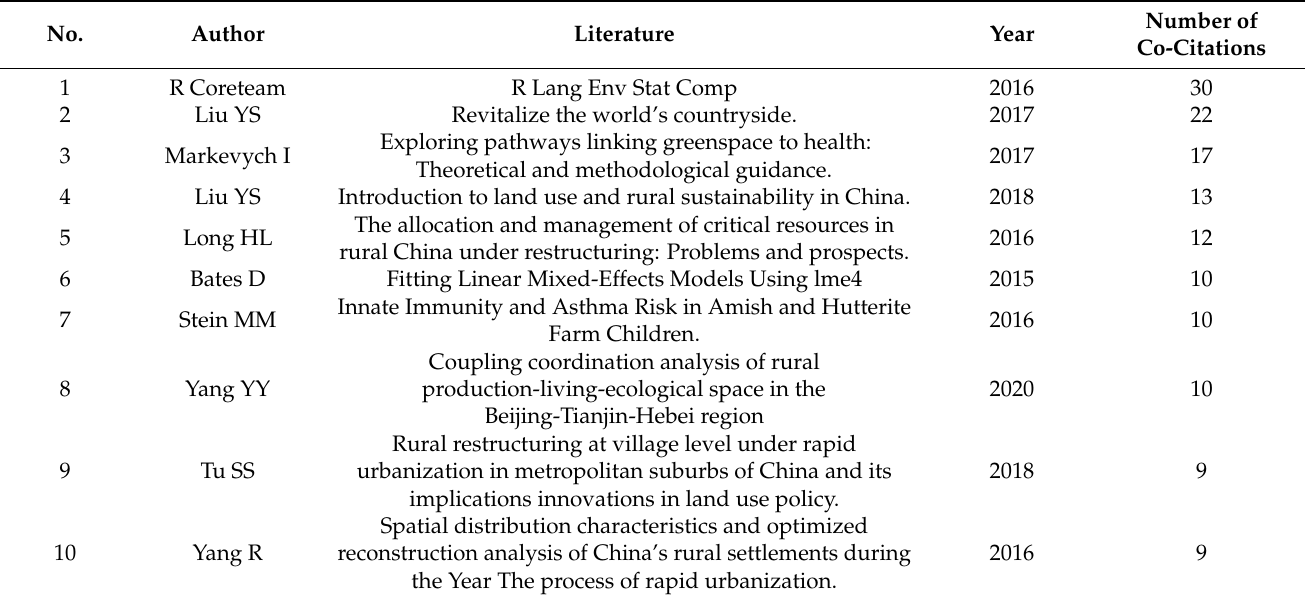
Table 6. Key literature nodes of rural human settlement environment research.